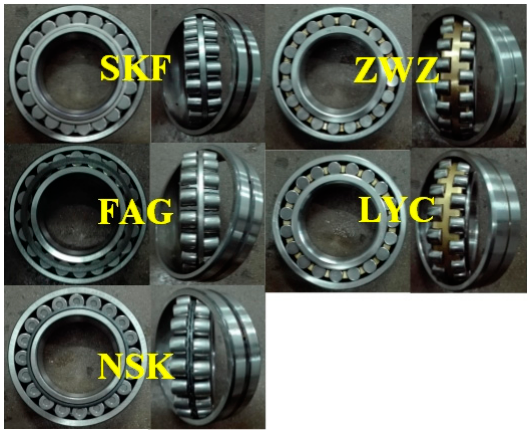
Figure 9. SRBs with different brands.